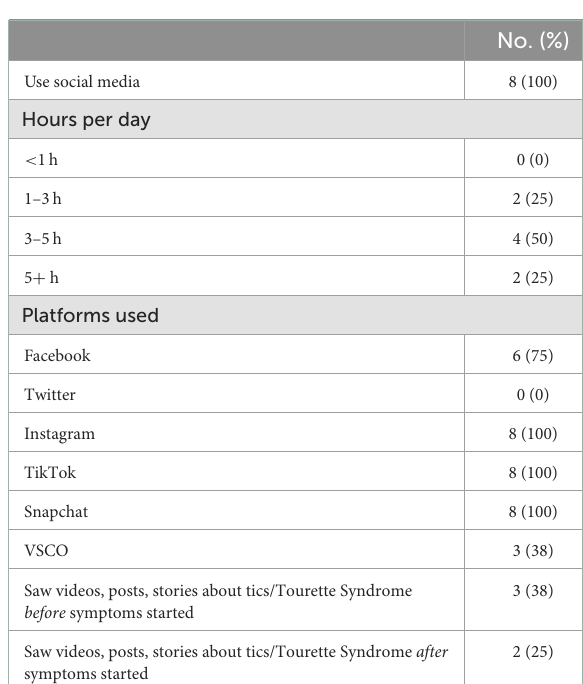
TABLE 2 Self-reported social media use and behaviors of persons experiencing functional tic-like behaviors, Minnesota, September–November